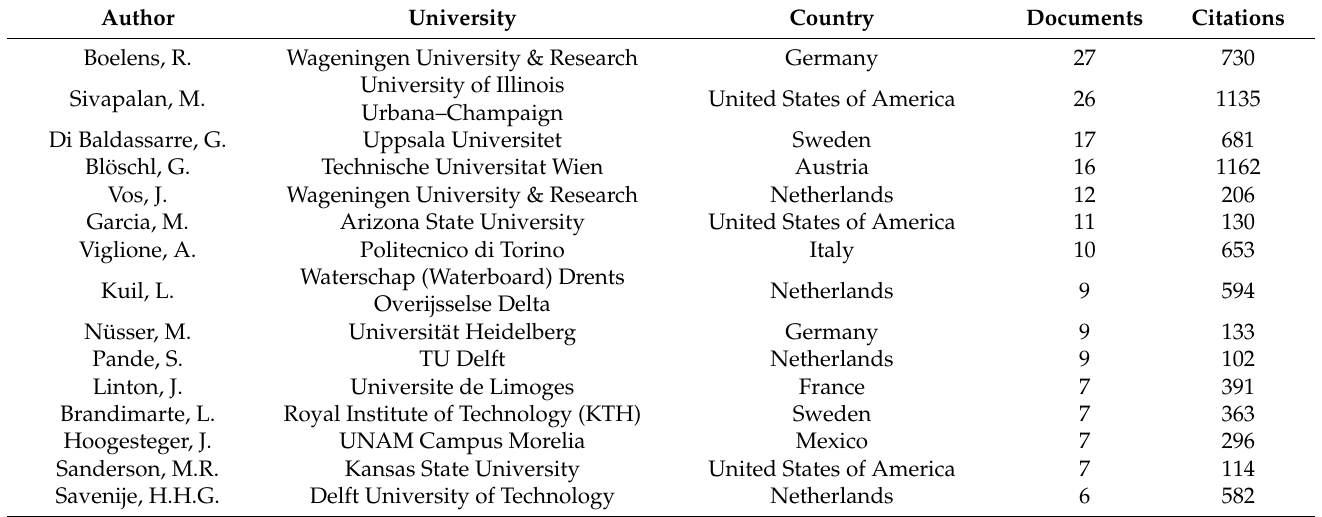
Table 2. Top 15 featured